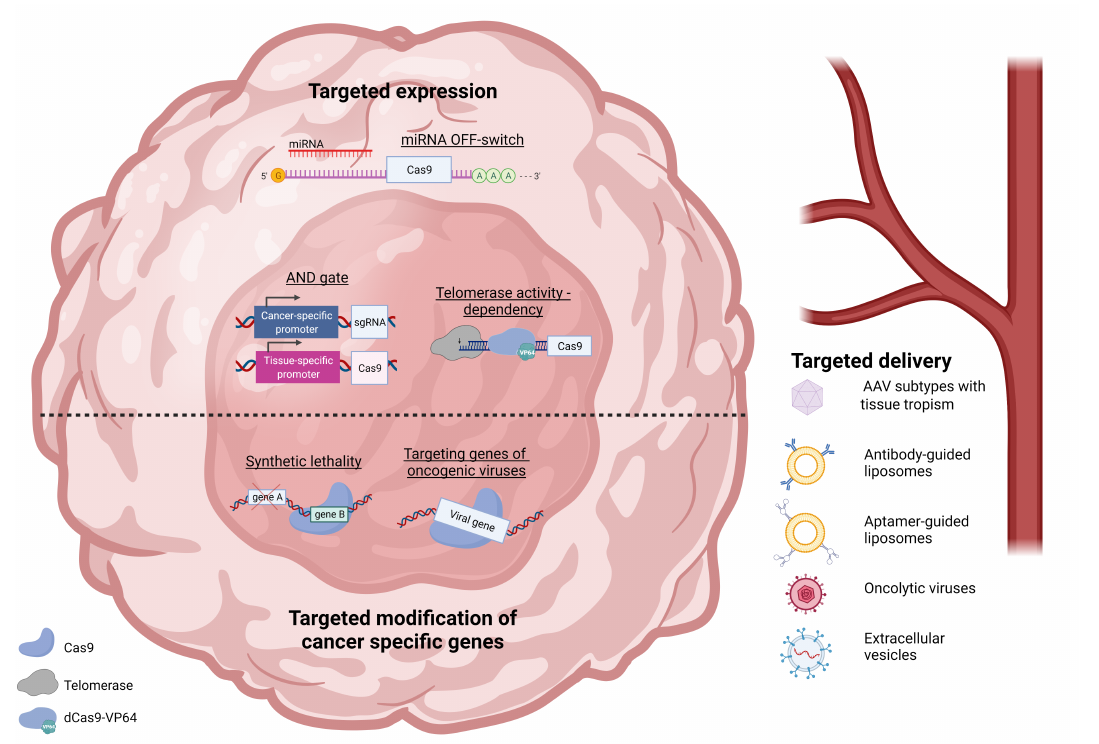
Figure 1. Summary of recently explored strategies for targeted CRISPR/Cas9 gene engineering in cancer therapy. Targeted delivery of CRISPR/Cas9 system can be achieved by employing vectors, such as: certain Adeno-associated virus serotypes with tropism to various tissues; liposomes guided to cancerous cells by specific antibodies or their protein-free counterparts - aptamers; oncolytic viruses